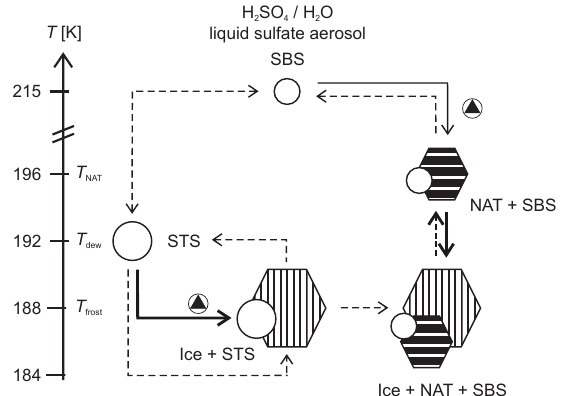
Fig. 1. PSC formation pathways implemented into ZOMM (Zurich Optical and Microphysical box Model) with SBS=supercooled binary solution (H 2 SO 4 / H 2 O); STS=supercooled ternary solution (HNO 3 / H 2 SO 4 / H 2 O); NAT=nitric acid trihydrate (HNO 3 · 3H 2 O); N =foreign nuclei, e.g. meteoritic dust, immersed in STS aerosol droplets (surrounded by circle). Dashed arrows denote pathways included in previous schemes (e.g. following Lowe and MacKenzie, 2008; Peter, 1997). Solid arrows show the heterogeneous nucleation pathways of NAT and ice on pre- existing solid particles supported by the new field observations. Thick arrows are discussed within this publication; the thin solid arrow is discussed in companion paper (Hoyle et al., 2013). Note that some arrows are unidirectional (i.e. the other direction is thermodynamically not possible), while others are